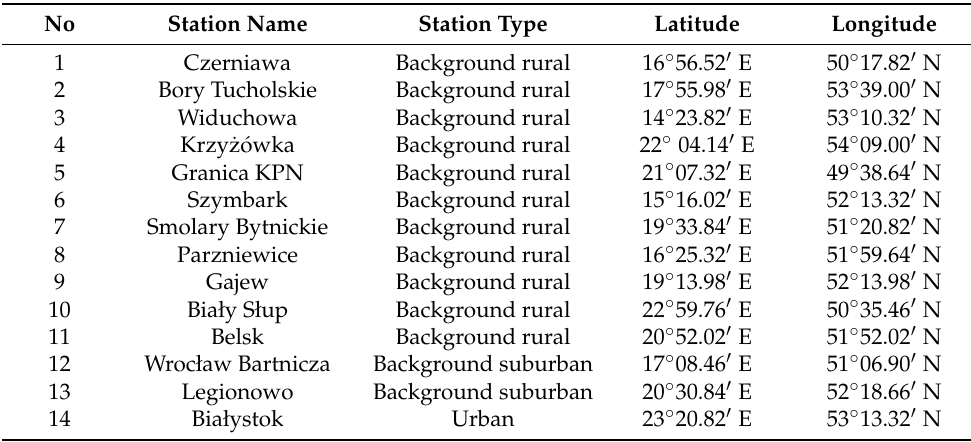
Table 2. Surface air quality stations used in the